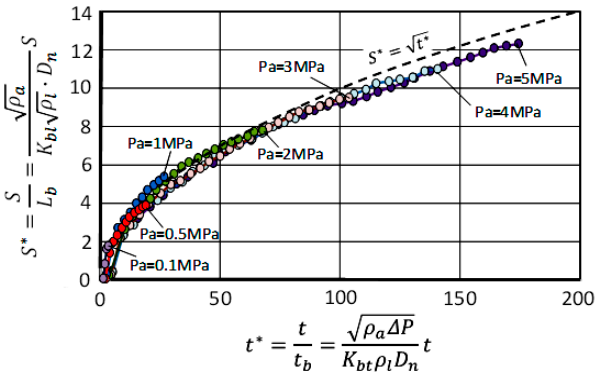
Figure 9. Non-dimensional spray tip penetration normalized by breakup scale. Plot indicated by leader line of pressure condition shows the 100 mm penetration position of each spray.